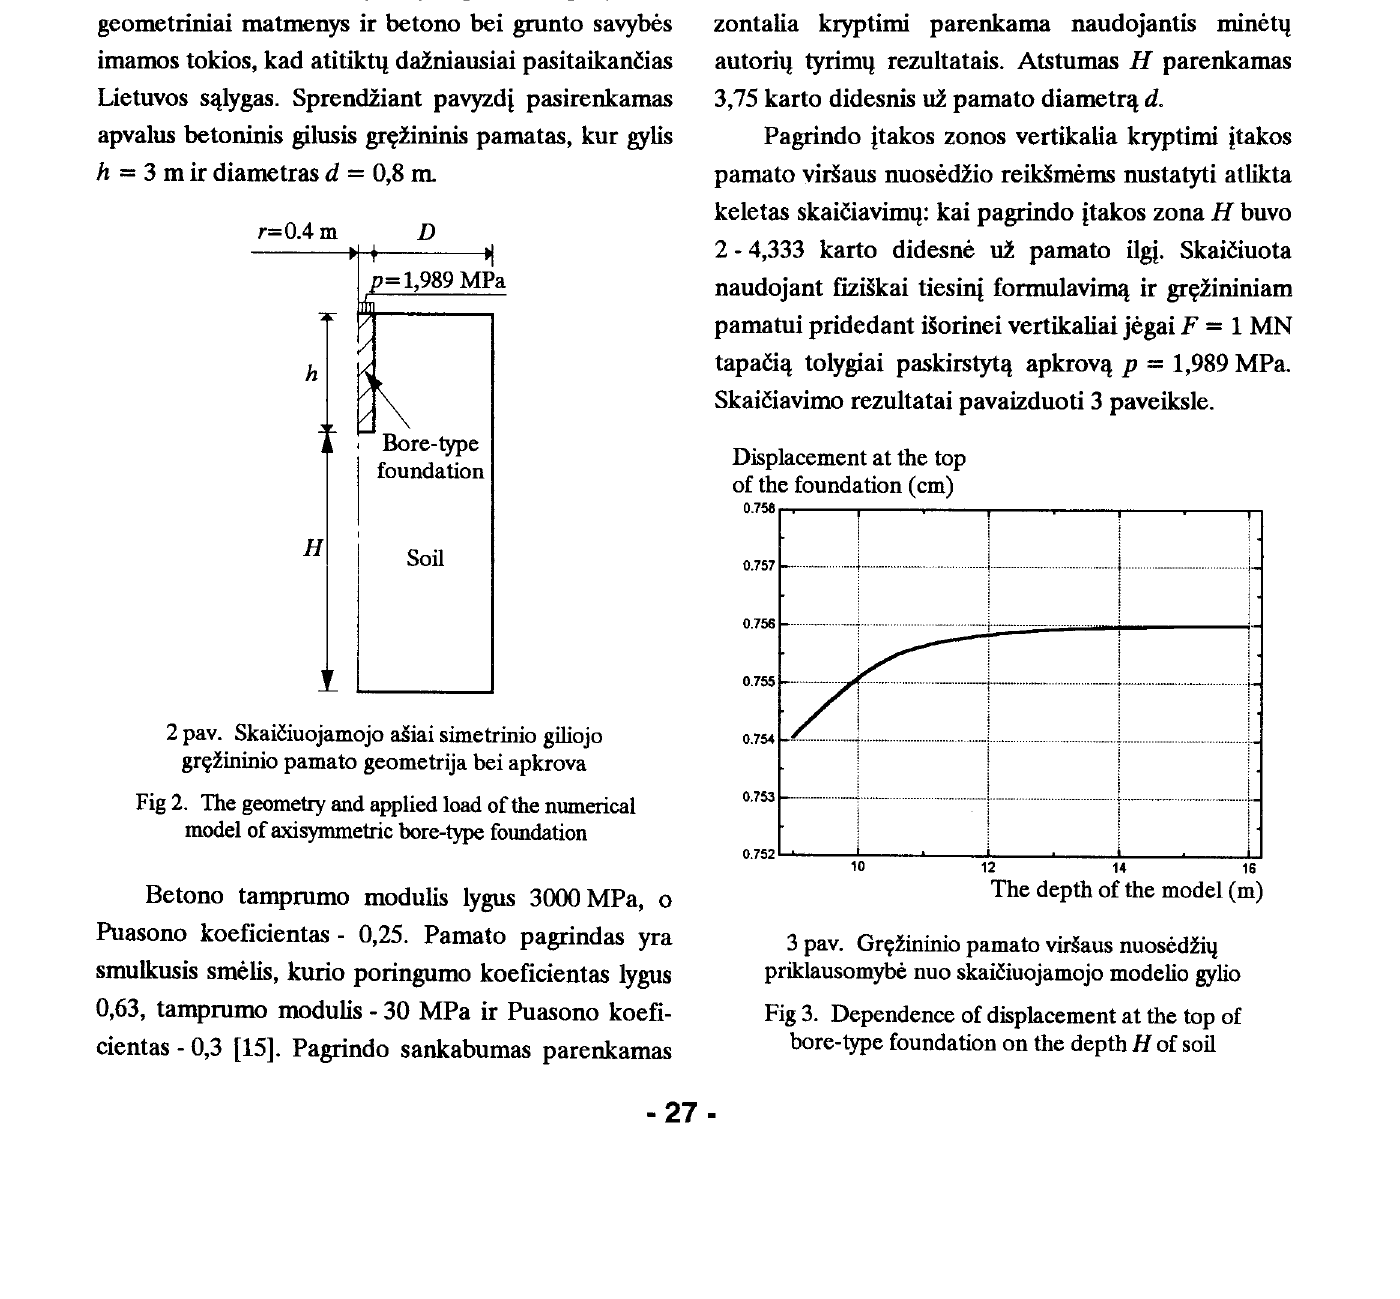
Fig 2. The geometry and applied load of the numerical model of axisymmetric bore-type foundation